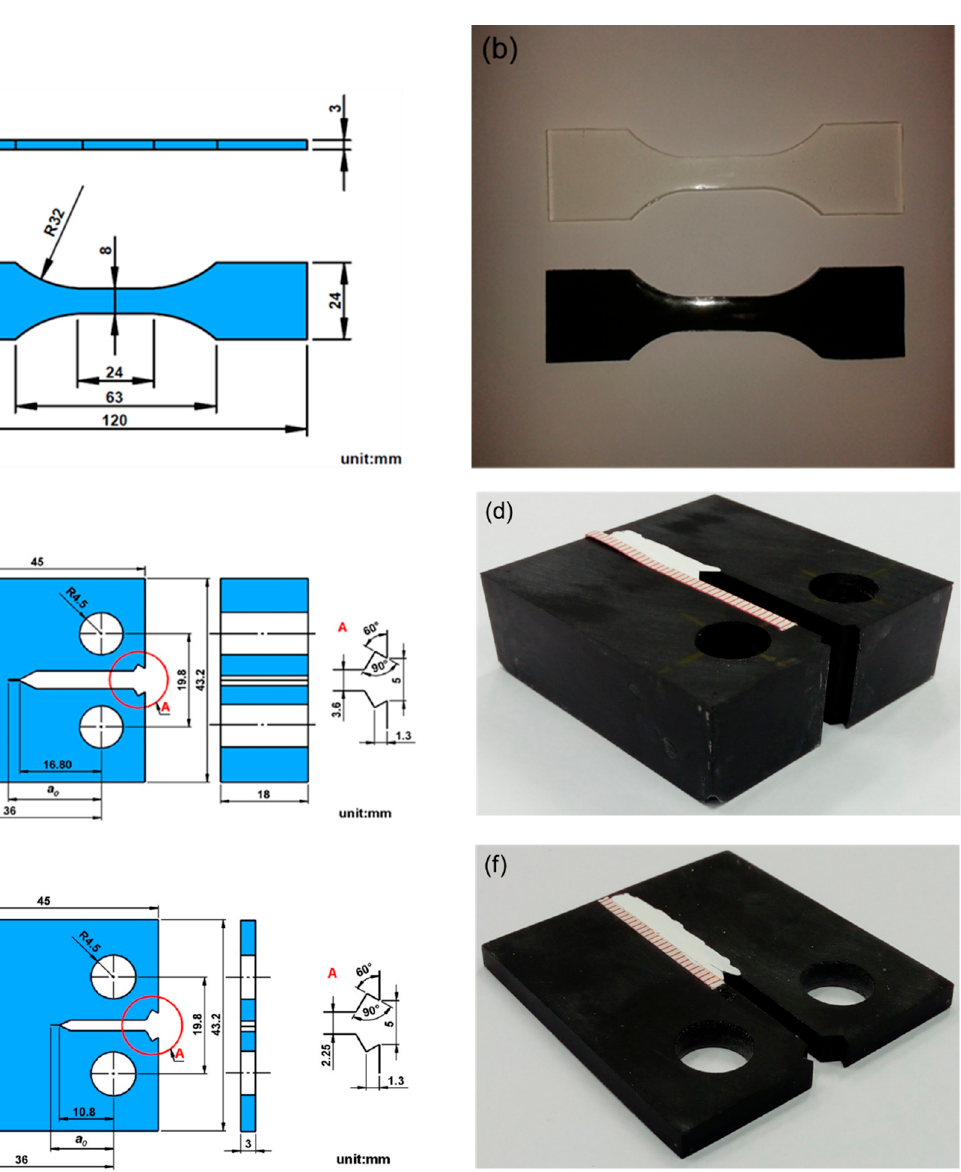
Figure 2. ( a ) Shape and dimensions of the tensile / fatigue specimen; ( b ) photograph of tensile / fatigue specimens; ( c ) shape and dimensions of the compact (CT) specimen employed in the fracture toughness tests; ( d ) photograph of the CT specimen employed in the fracture toughness tests; ( e ) shape and dimensions of the CT specimen employed in the crack propagation tests; and ( f ) photography of the CT specimen employed in the crack propagation